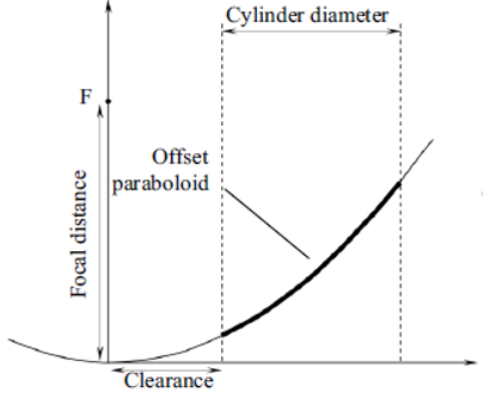
Fig. 3. Offset paraboloid surface diagram The offset paraboloid parameters values were: cylinder diameter -12m; focal distance - 5.4m; clearance –